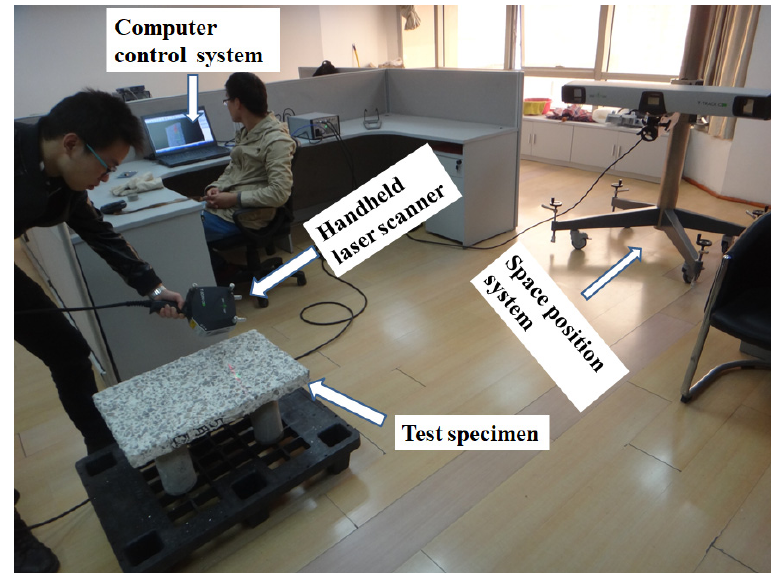
Figure 4. 3D laser scanning system produced by Steinbichler.